Question: Summarize what this figure shows in one sentence.
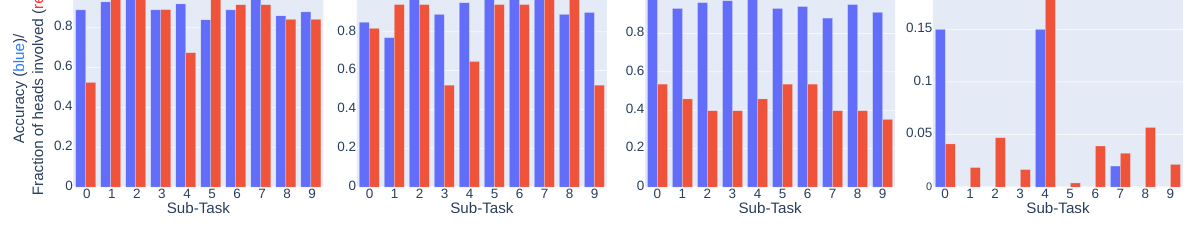
Answer: Performance of attention heads identified for each different subtask type across dif- ferent subtasks. We show the performance of (a) decision-making, (b) copy, and (c) inductive reasoning heads for each subtask 0 to 9 (blue bars show accuracy when the rest of the heads are knocked out; red bars denote the fraction of heads involved, see Figure 1 for subtask annotation). (d) Task-only heads are only those that are not shared with other tasks, e.g., only those copying heads for subtask 4 that are not decision-making or inductive reasoning heads. Inductive reasoning heads are consistently functional across all the subtasks with the least number of heads involved.